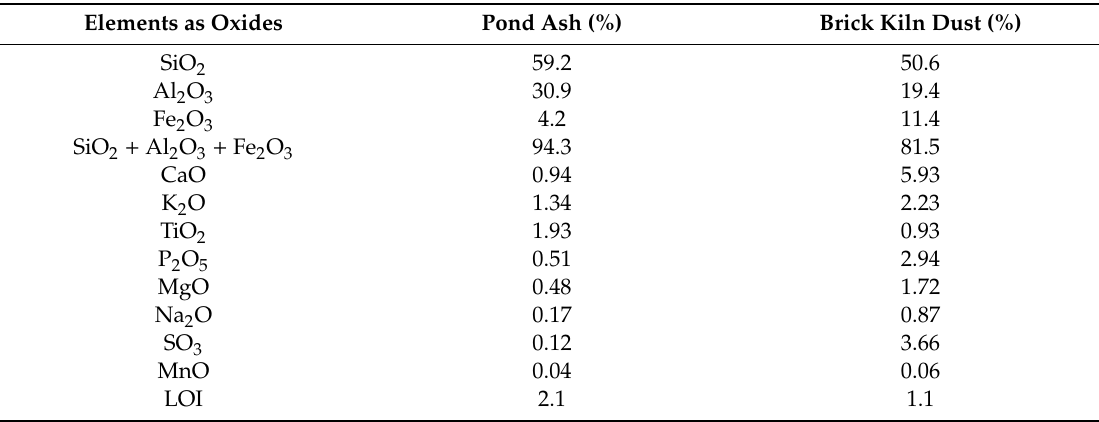
Table 4. Chemical composition of pond ash and brick kiln